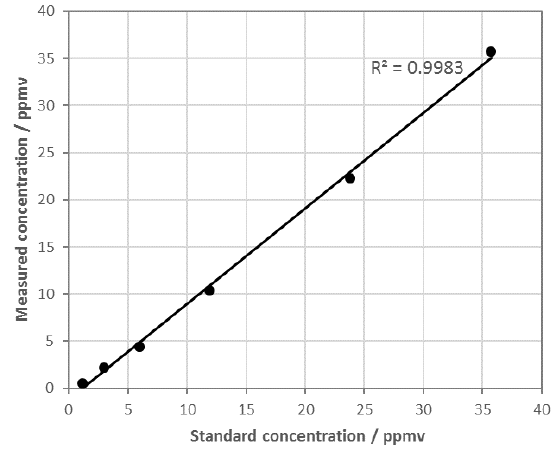
Figure 5. Comparison of a SIFT-MS measurement against the concentration of a certified mixture of HCl in nitrogen using the NO 2 − reagent ion.